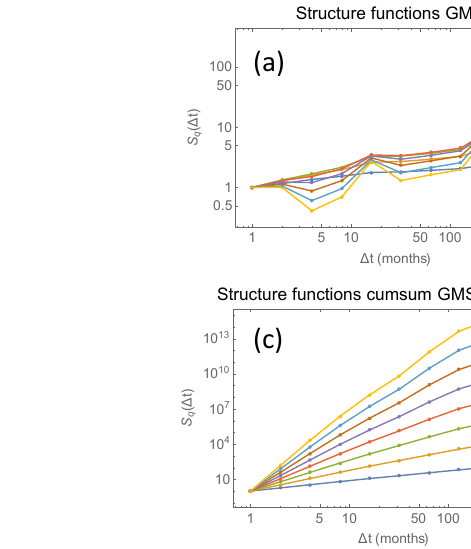
N − (cid:49)t P | T ( t i + (cid:49)t ) − T ( t i ) | q for the GMST (Had- i = 1 i P = T ( t j ). (c) Structure func- i j = 1